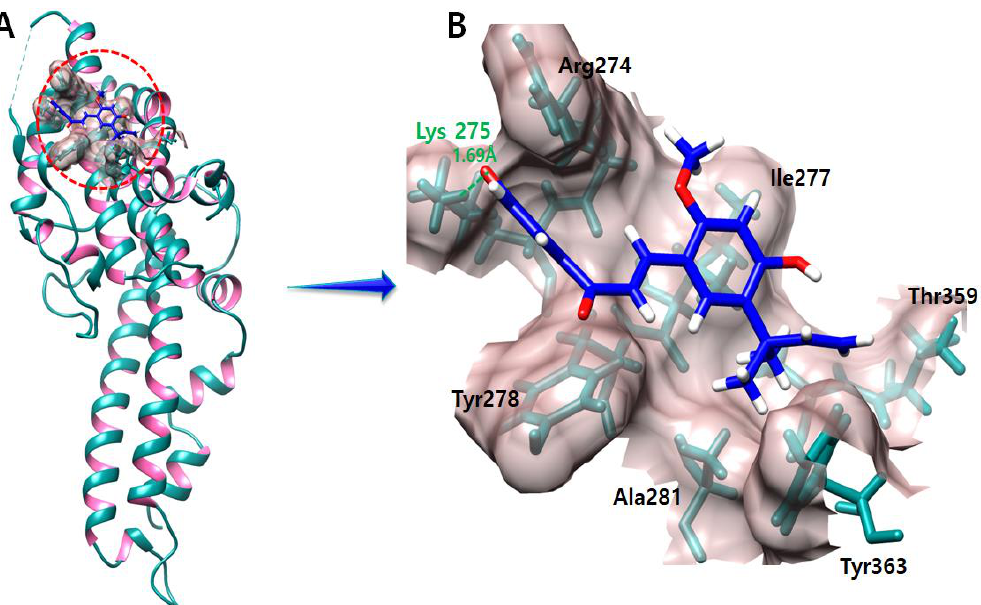
Figure 7. The licochalcone A – DBP complex is depicted in this figure ( A ). In Figure ( B ) salt bridge produced during the docking experiment is shown in green color. An oxygen atom forms a salt bridge with the Lys275 with a length of 1.69 Å .